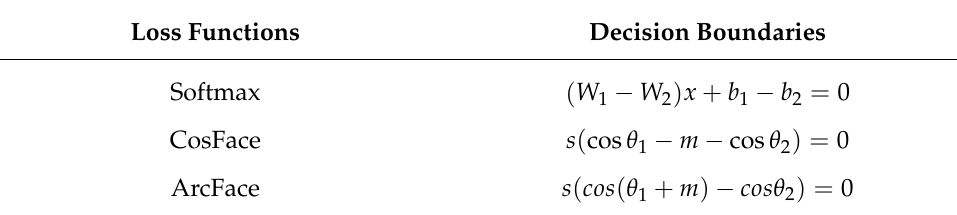
Table 1. Comparing binary classification decision